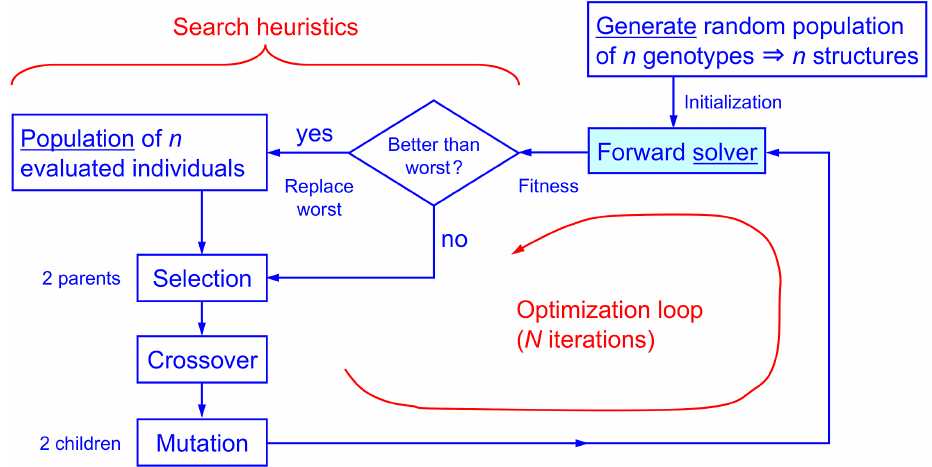
Figure A1. schematic of the breeder evolutionary algorithm’s working